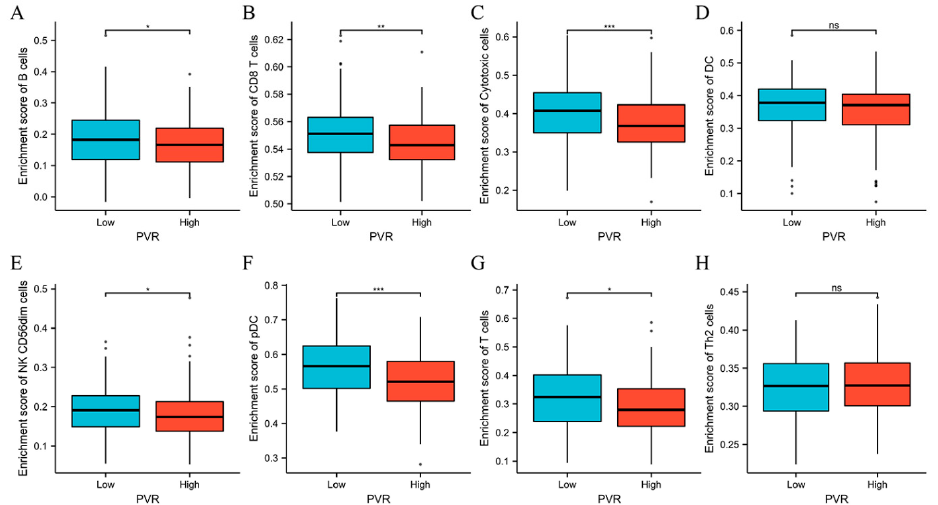
Figure 7. Comparison of immune cells between high and low PVR expression groups. ( A – H ) Histogram showing the difference of B cells, CD8+ T cells, cytotoxic cells, DC, NK CD56dim cells, pDC, T cells, and Th2 cell infiltration level between high and low PVR expression groups. * p value < 0.05; * * p value < 0.01; ** * p value < 0.001.